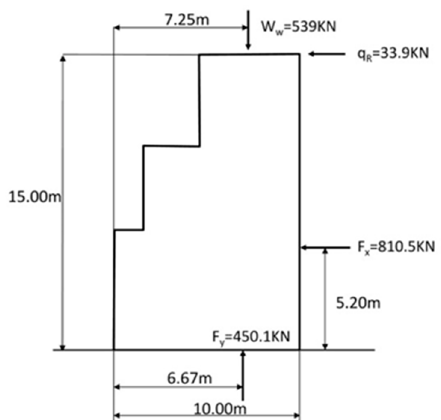
Figure 3. Load state A, used for crown wall design (Wave height Hs (m) = 15.1; Peak period Tp (s) = 20), [11].